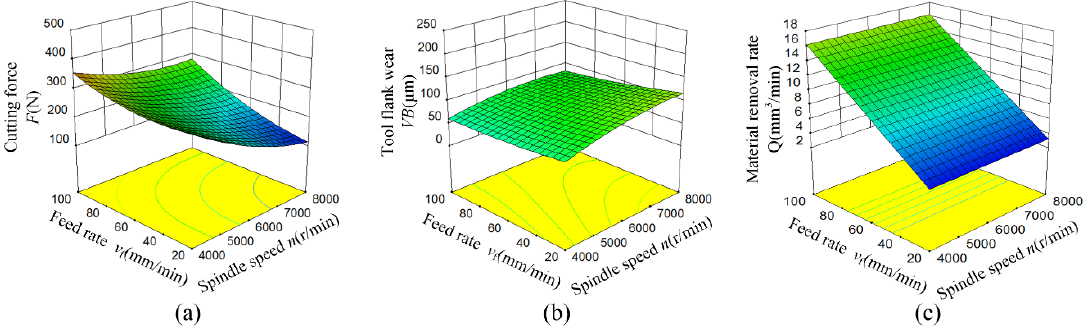
Figure 4. Response surface of spindle speed and feed rate on cutting force, tool flank wear and material removal rate. ( a ) Cutting force F , ( b ) Tool flank wear VB , ( c ) Material removal rate Q .